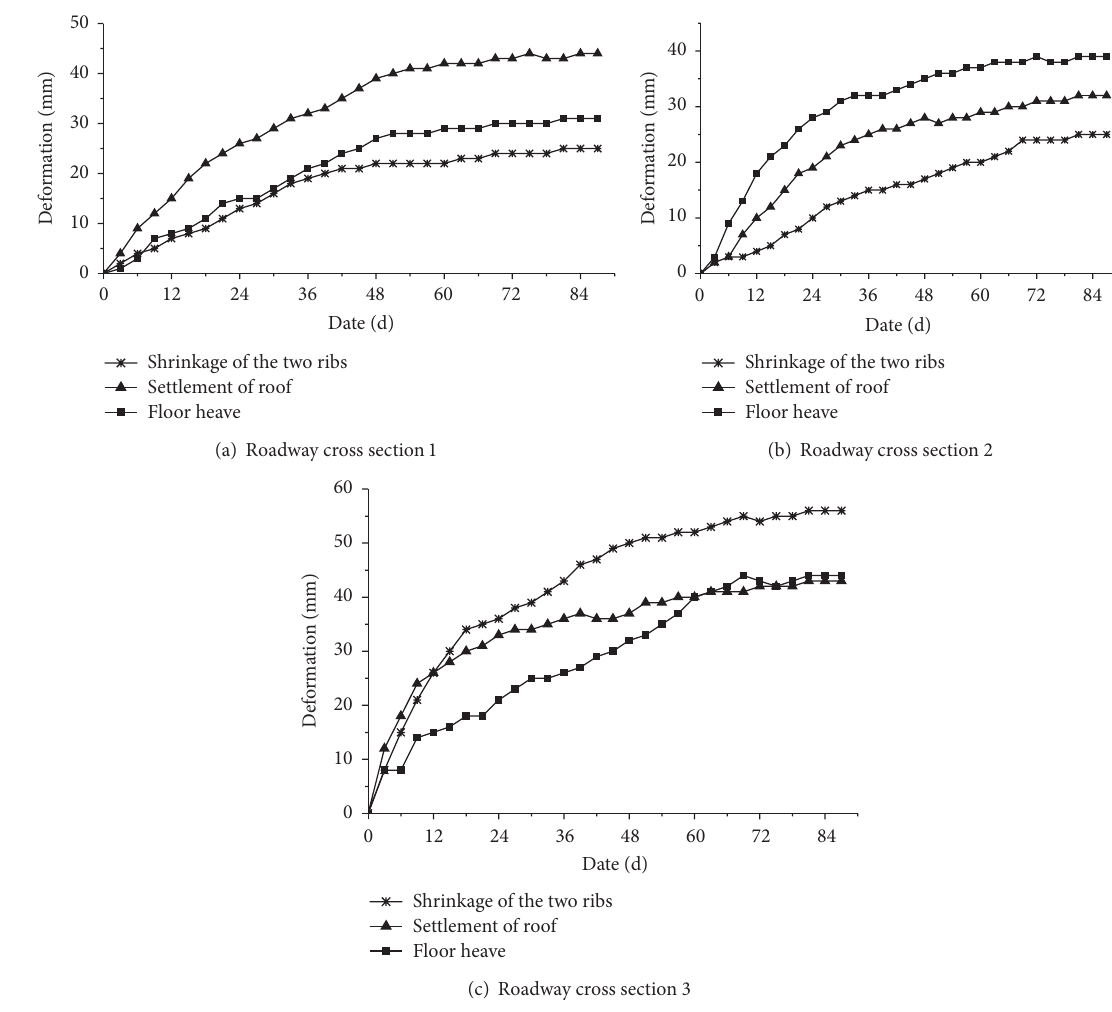
Figure 13: The cumulative deformation of the roadway with the new support